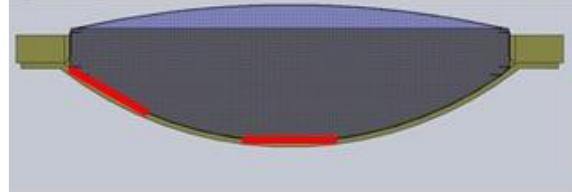
Fig. 1. Schematic view of witness sample positions. A cut of a lens is depicted in blue and two possible positions for witness samples in red. Any position along the lens surface can be chosen.